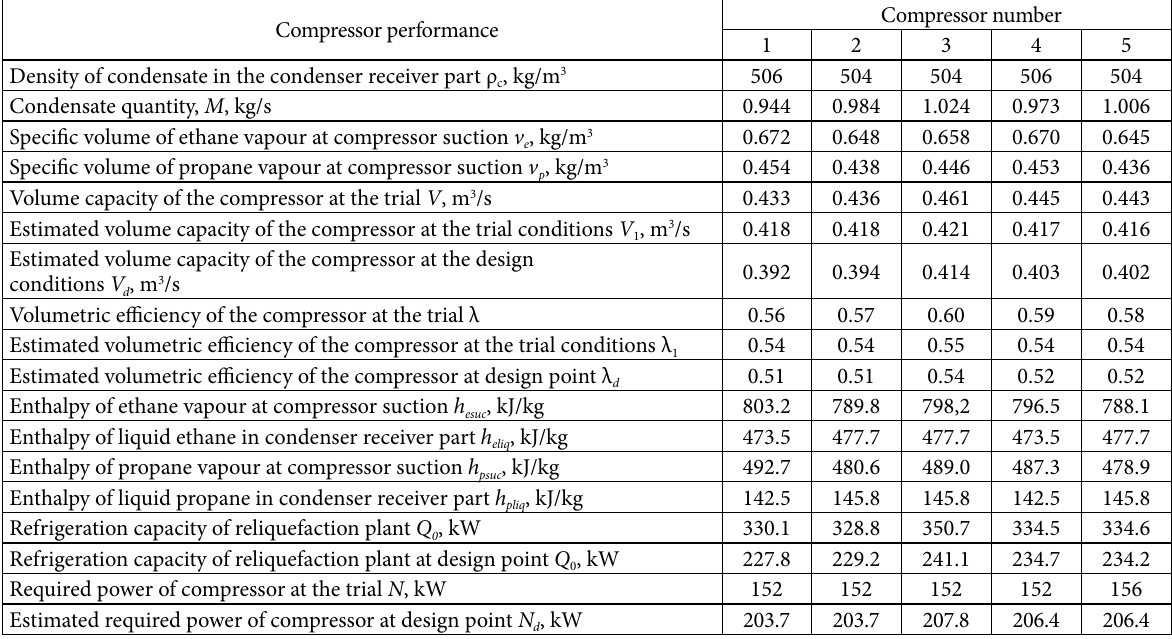
Table 3. Trial conditions and design sonditions of the reliquefaction plant Compressor